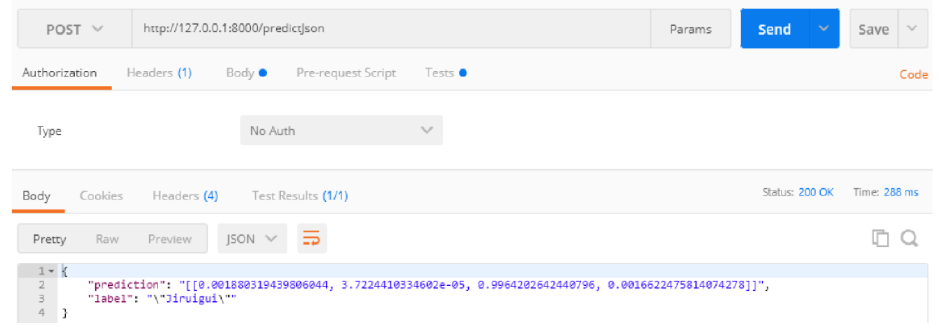
Figure 18. POST inference response .